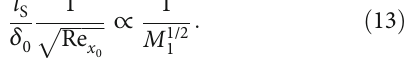
Figure 10: Simulated cases at the low Mach number ( 2 ≤ M correlation of the Reynolds number with the initial fl ow de fl ection